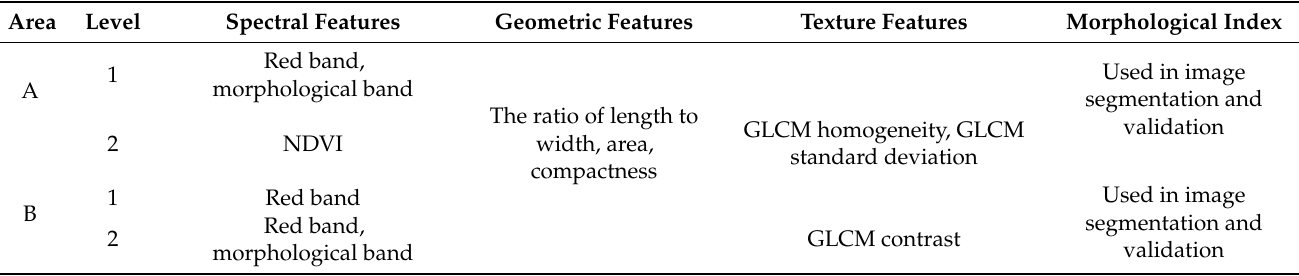
Table 3. Classification features